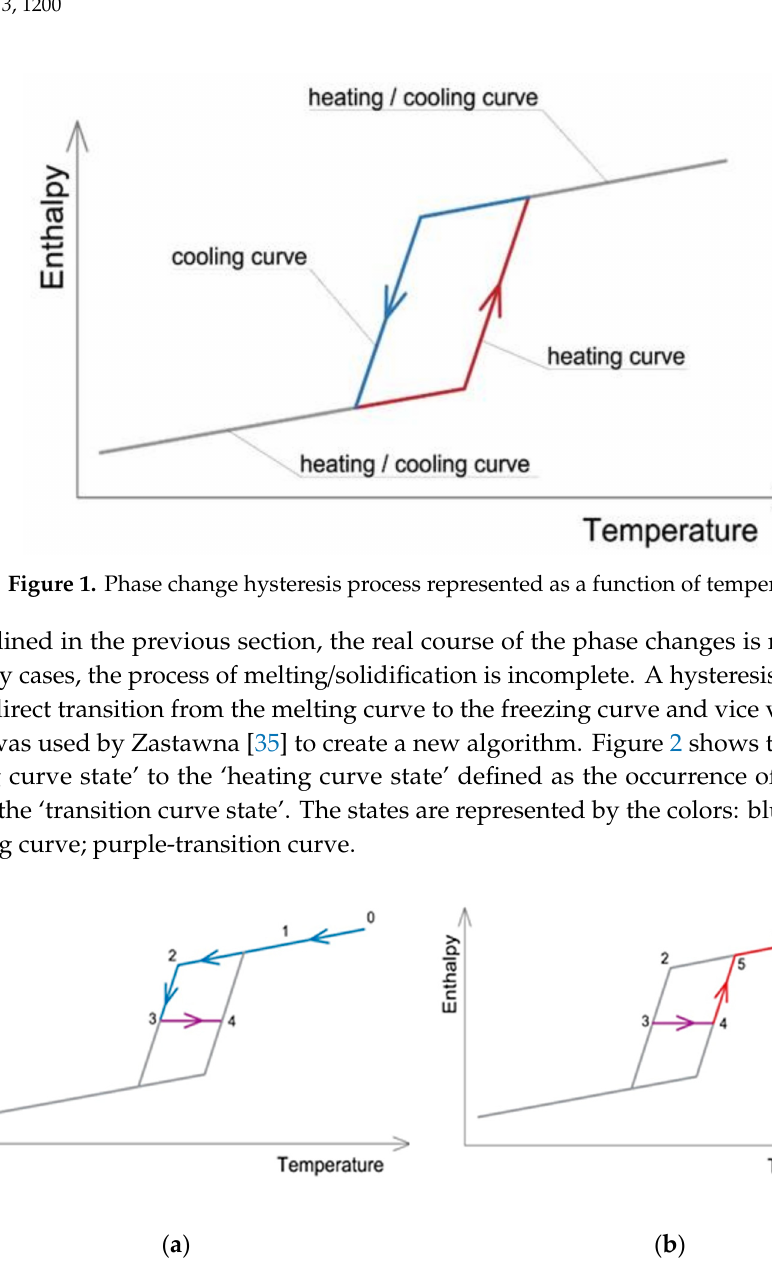
Figure 2. Intermediate transition curve between solidification ( a ) and melting ( b ) curves.